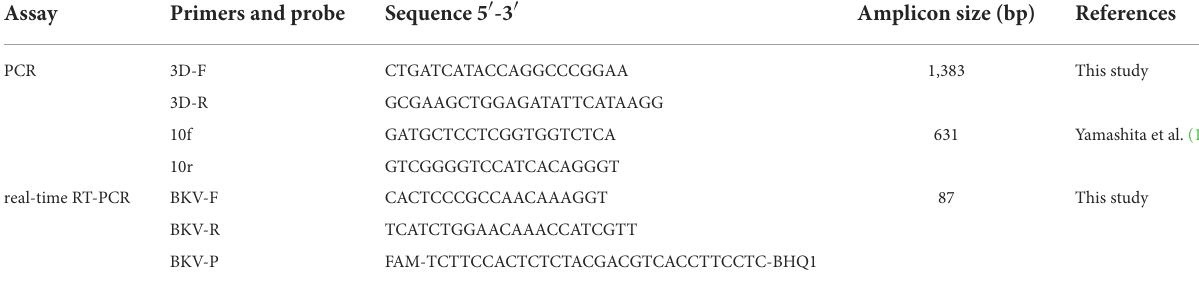
TABLE 2 Sequences of the primers and probe for BKV RT-PCR and real-time RT-PCR